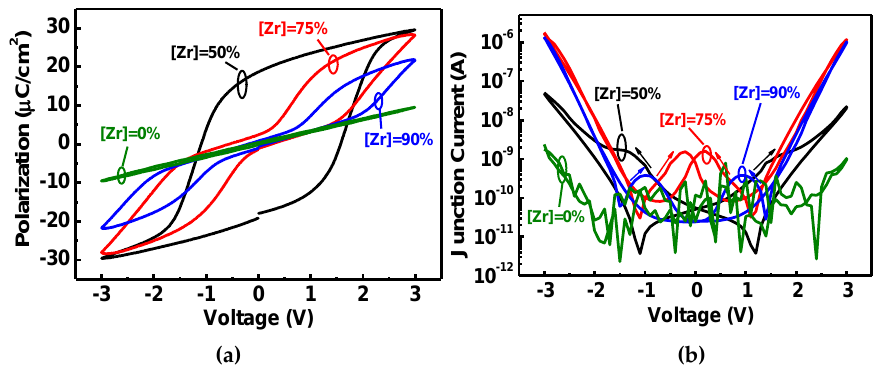
Figure 7. The HZOs with the [Zr] = 0%, 50%, 75%, and 90% diodes for the double bipolar sweep ( − 3 V to 3 V and back to − 3 V) for the ( a ) P-V and ( b ) I-V characteristics.